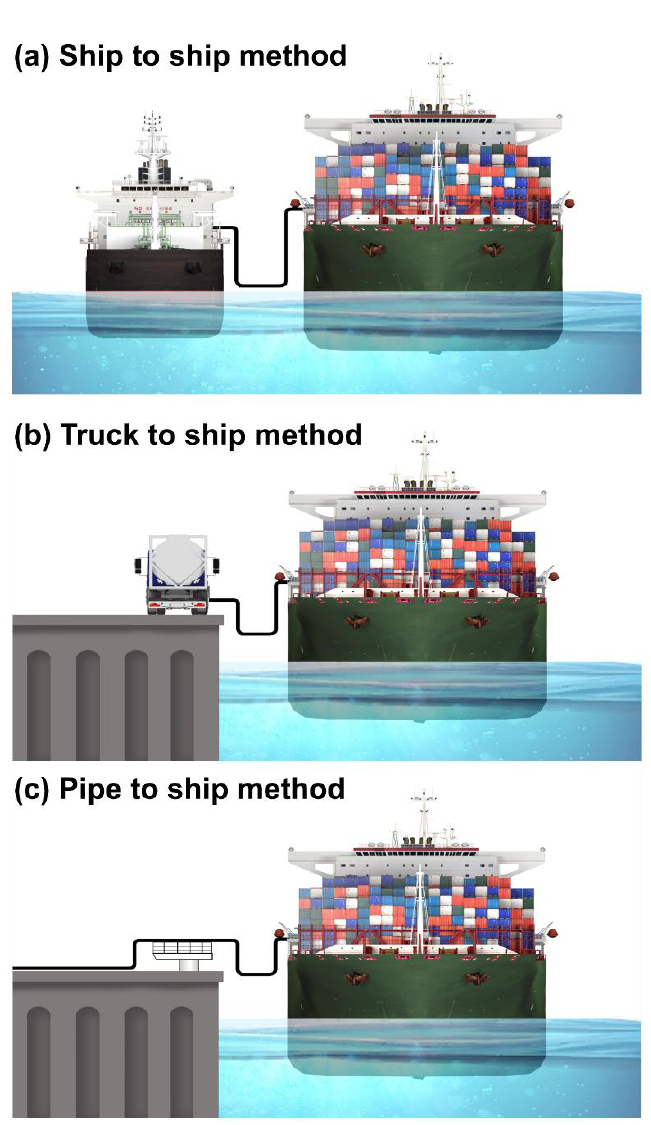
Figure 2. LNG Bunkering methods: ( a ) ship to ship method, ( b ) truck to ship method, and ( c ) pipe to ship method.